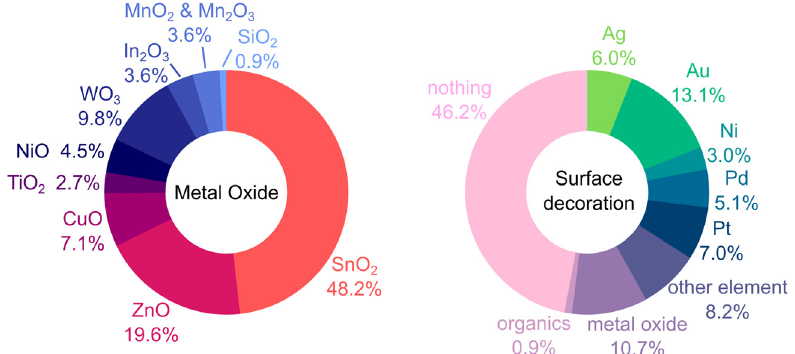
Figure 15: Frequency of use of di ff erent metal oxides in the fabrication of electronic noses based on nanowires ( left ) ; frequency of use of di ff erent materials as super fi cial decoration for MO nanowires ( right )